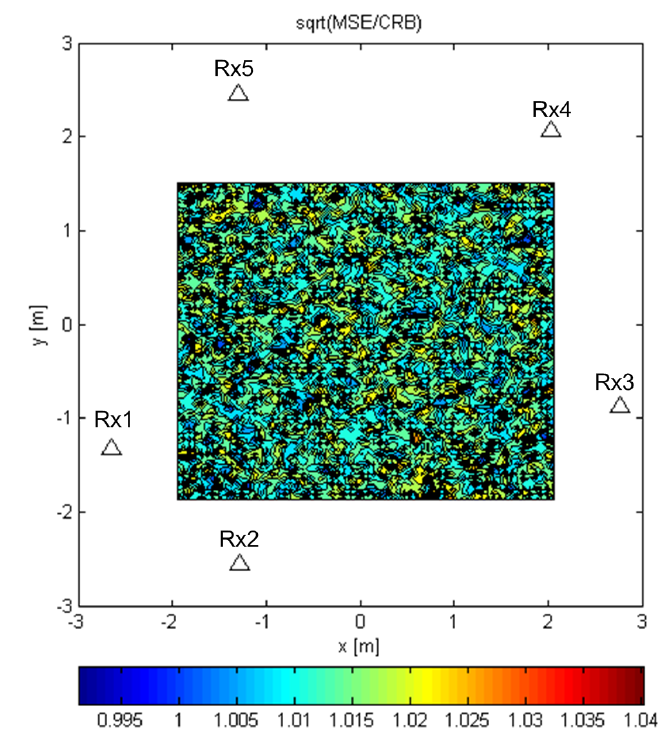
Figure 9. ML-US MSE/CRB for random Gaussian